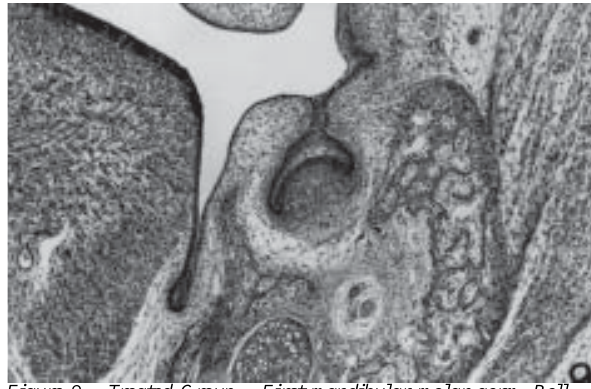
Figure 9 – Treated Group – First mandibular molar germ. Bell- shaped phase. H&E. Magnification: 125X.